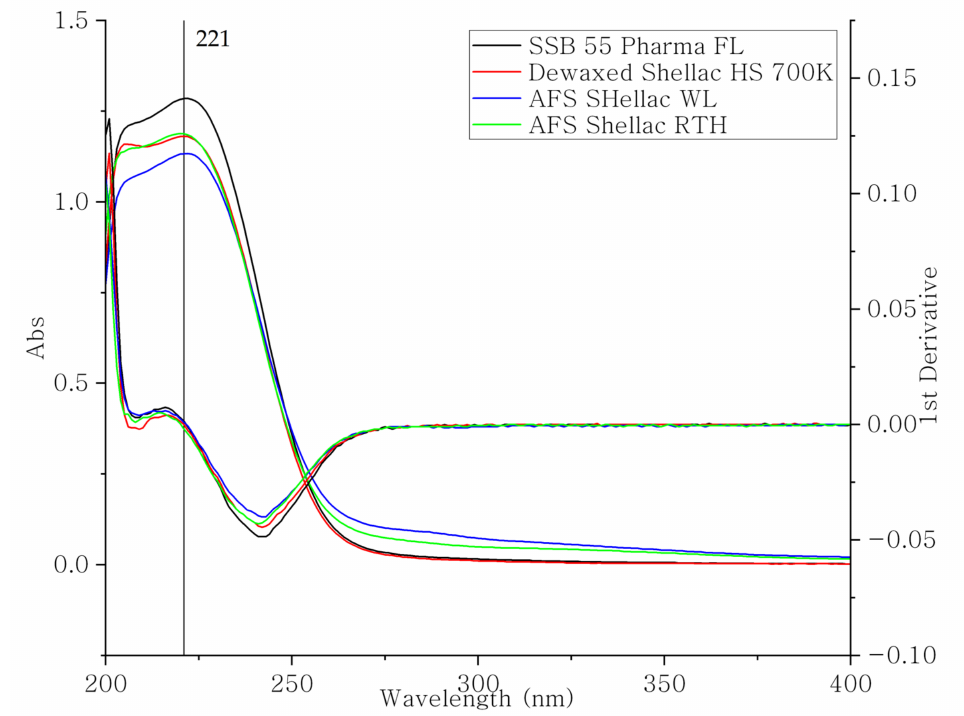
Figure 7. The UV spectrum and its 1st derivative curve of four different types of